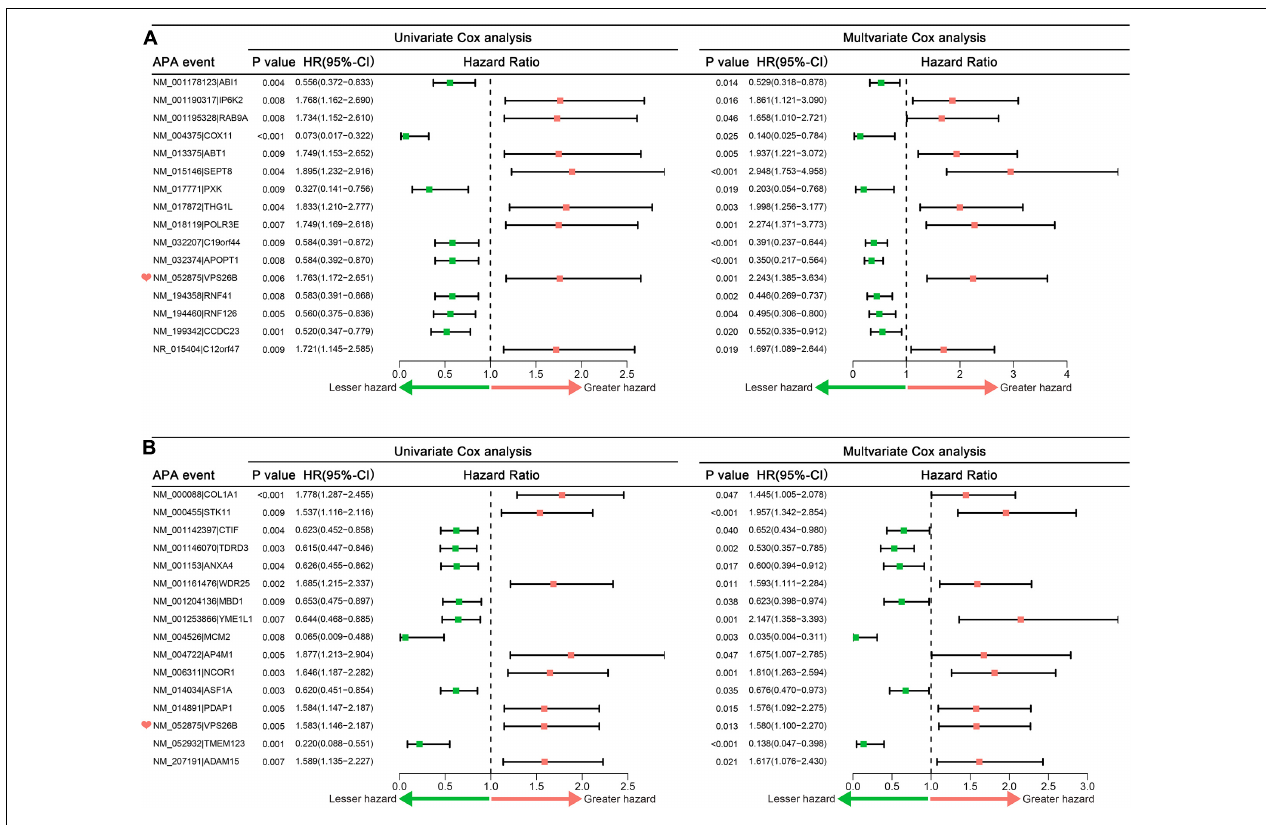
FIGURE 2 | Forrest plots of hazard ratios of prognosis associated APA events in sarcoma patients. (A) Univariate and multivariate Cox analysis results of independent OS-related alternative polyadenylation events. (B) Univariate and multivariate Cox analysis results of independent PFS-related alternative polyadenylation events. APA, alternative polyadenylation; OS, overall survival; PFS, progress free-survival.